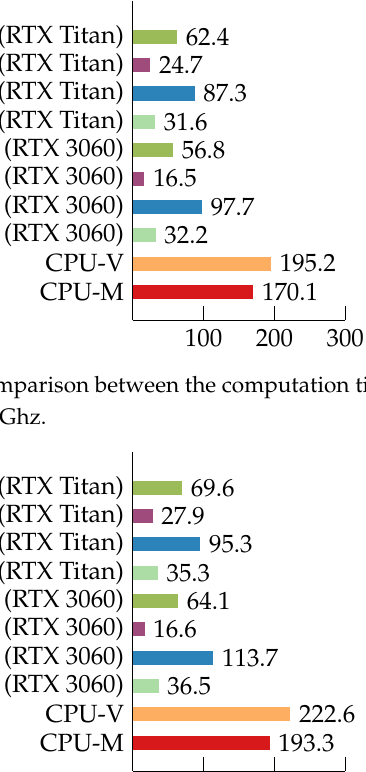
Figure 7. Comparison between the computation times obtained for propagation in open free space at 2.45 Ghz.